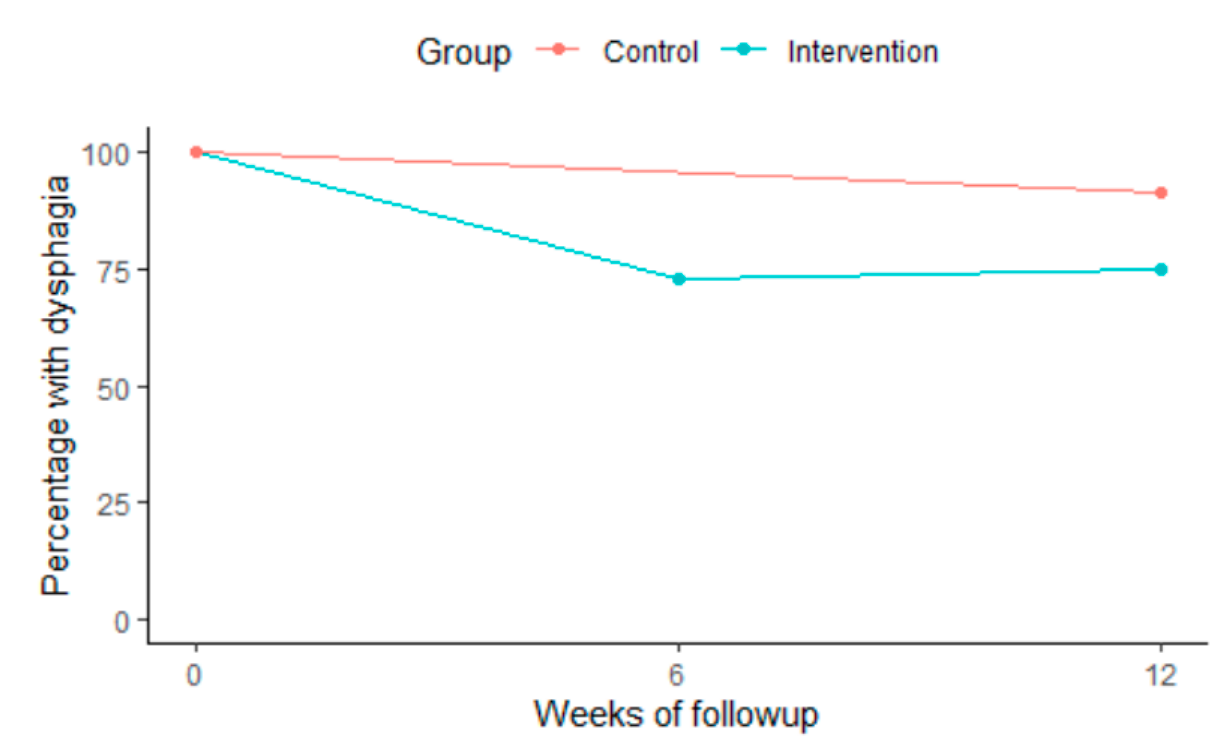
Figure 3. Percentage of participants with dysphagia over the study period among complete cases. Follow-Up